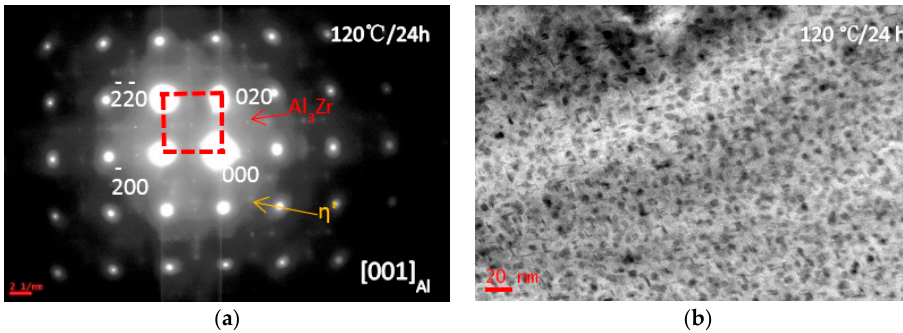
Figure 2. Bright-field (BF) images of the studied alloy having been solid solution treated at 470 °C for 1 h and then directly aged at 120 °C for 24 h. ( a ) SADP, the beam along zone axis of [100] Al ; ( b ) bright-field image.